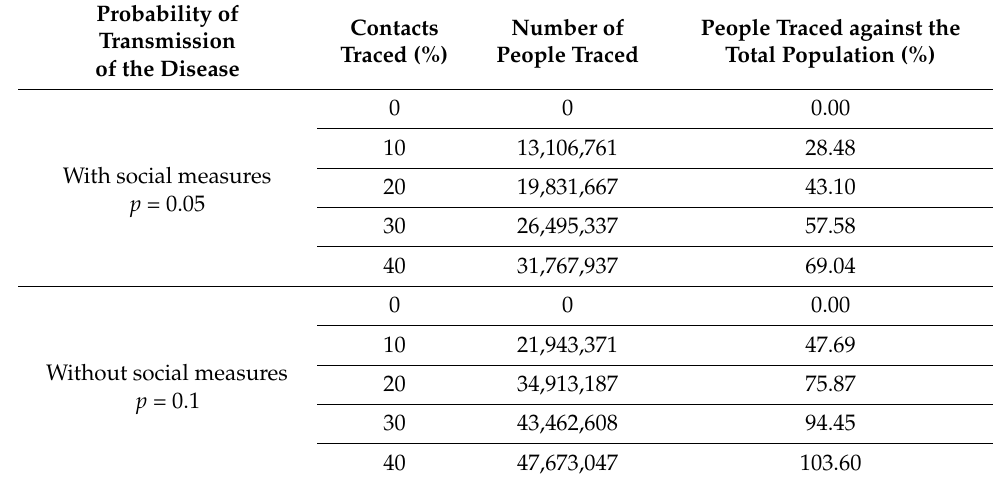
Table 8. Percentage of the total number of people who died or recovered depending on the percentage of contact tracing carried out in the population if there 19.56% of the population are protected by vaccination. Percentage of the Population No Vaccine With social measures Without social